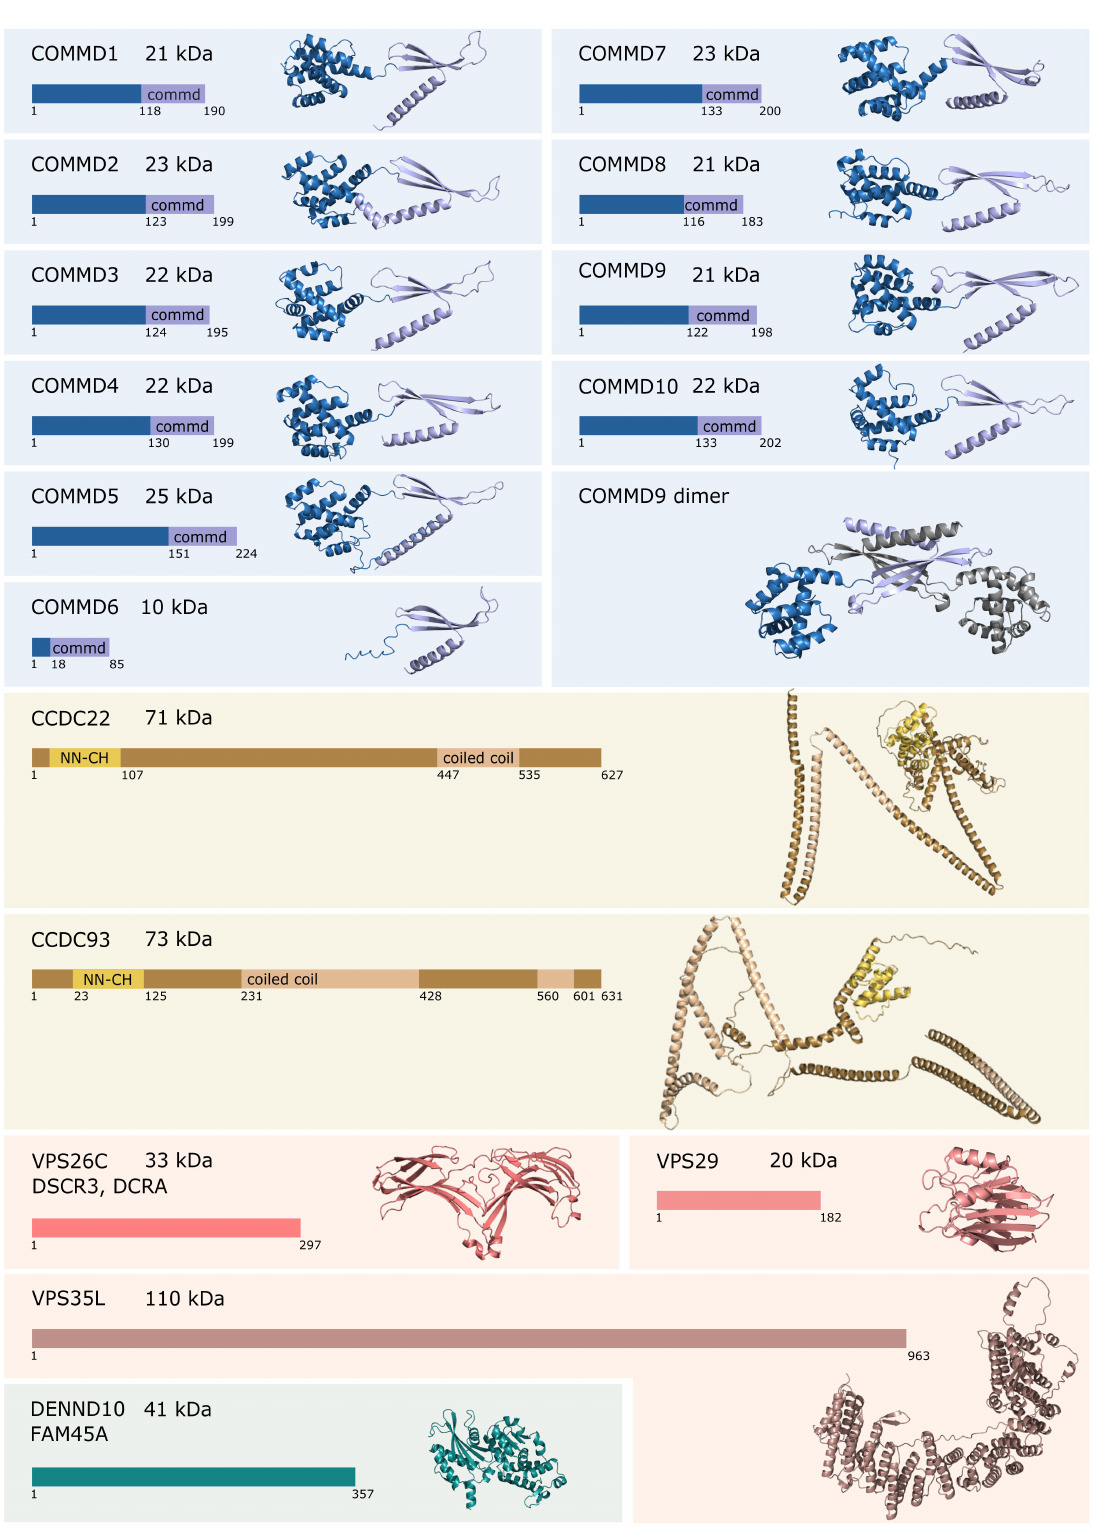
Figure 1. The predicted structures of commander complex proteins. The protein structures calculated by AlphaFold are presented in cartoon representation. Specific domains have been color coded according to the schematic presentation of the protein sequence on the left. VPS29 structure is from experimental data (PDB-code: 5GTU). The dimeric structure of COMMD9 has been generated combining the AlphaFold structure of COMMD9 with the crystal structure of COMMD9 COMMD domain (PDB-code: 6BP6) in PyMOL [44]. The second chain is shown in gray for